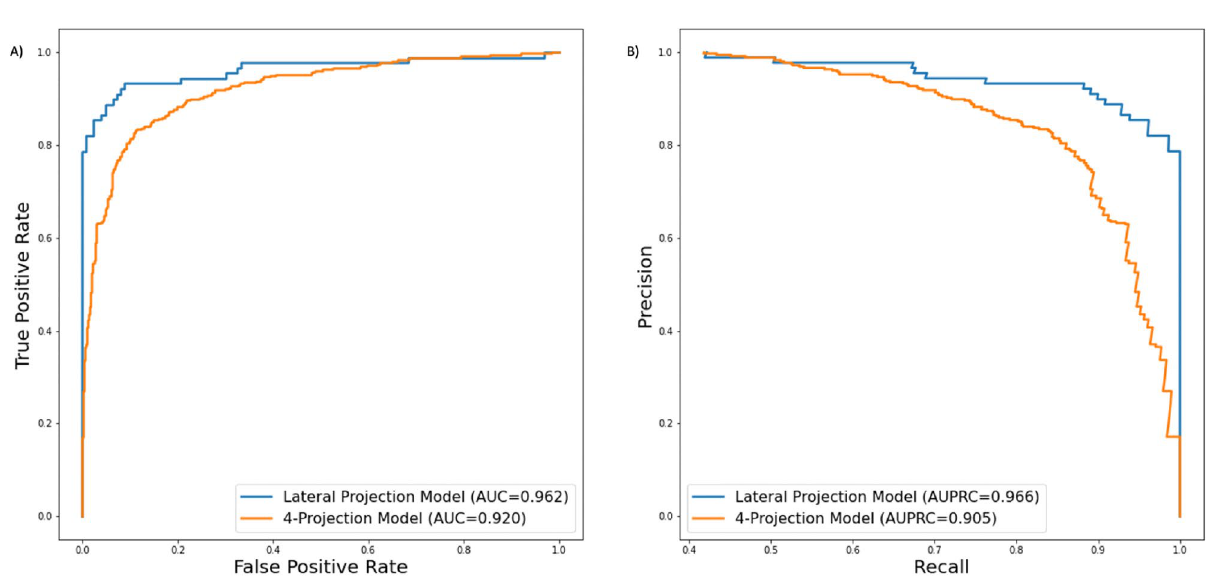
Figure 5. ROC AUC ( A ) and AUPRC ( B ) obtained from best training iterations for Models A (Lateral Projection data) and B (4-Projections data). AUC = Area Under the Curve and AUPRC = Area Under the Precision Recall